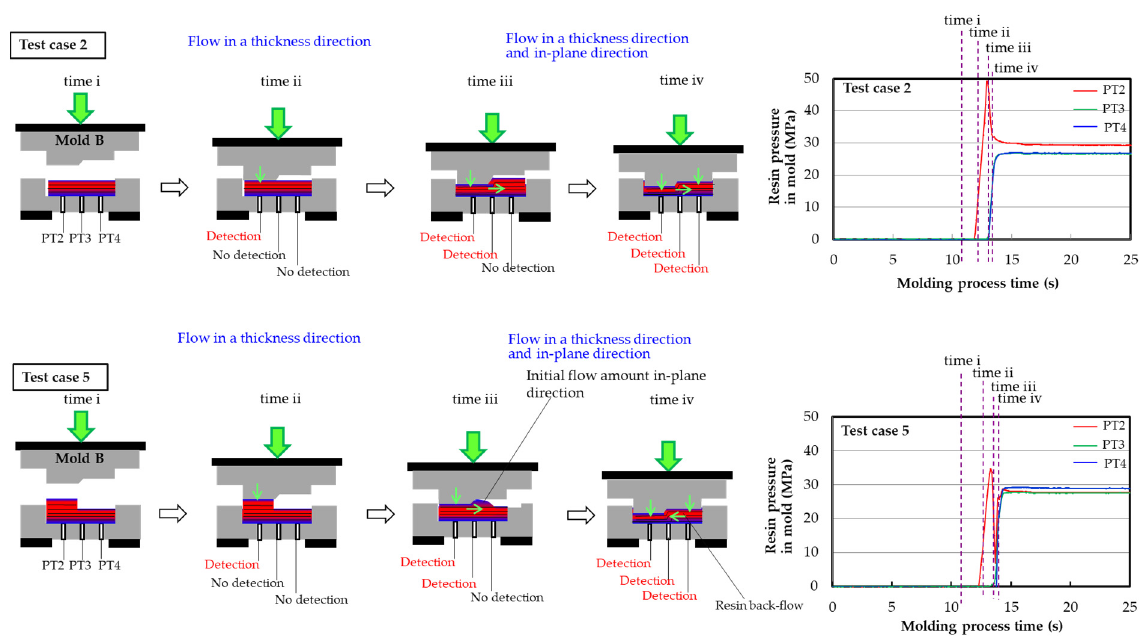
Figure 10. Resin flow mechanisms considered to influence the pressure time changes when each pressure overshoot oc- curs.